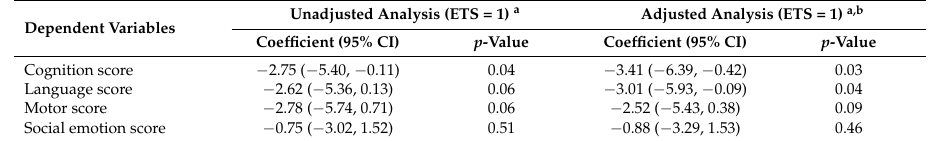
Table 3. Multivariate regression for prenatal exposure to ETS on child development in rural Guizhou province. Unadjusted Analysis (ETS = 1) a Dependent Variables